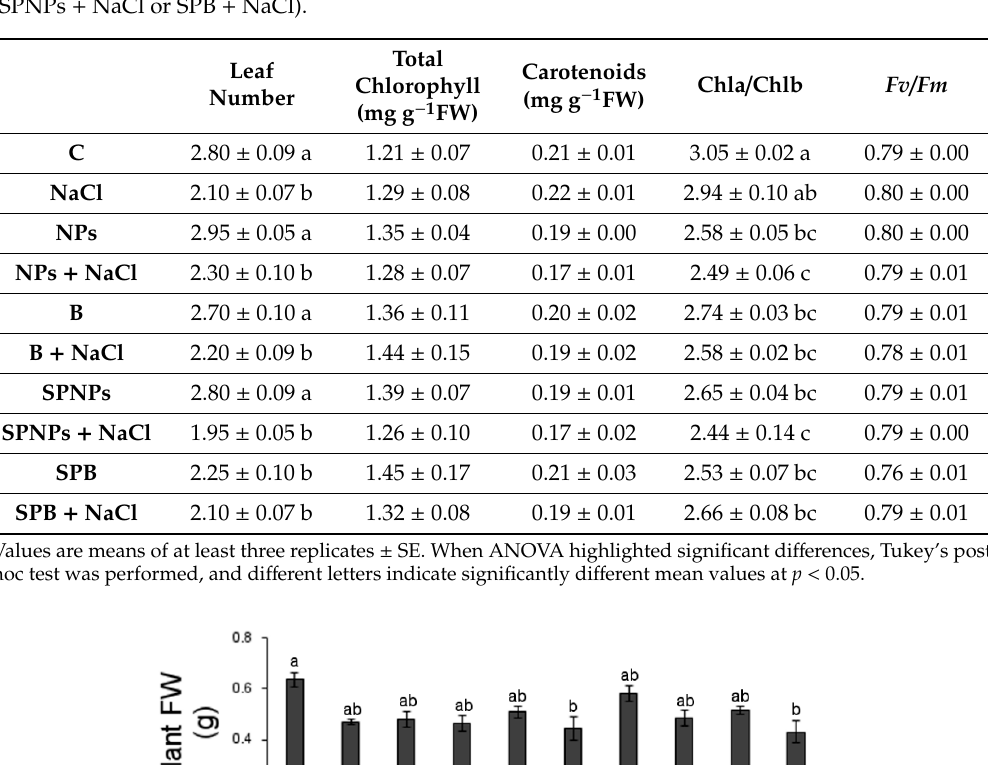
Table 2. Leaf number, pigment concentration, and maximum PSII quantum yield ( Fv / Fm ) in leaves of T. turgidum L. ssp. durum cv. Cappelli without priming and salt treatment (C), with salt treatment without priming (NaCl), with ZnO treatment in the root zone (nanoparticles, NPs or bulk form, B), with ZnO priming in the root zone with salt treatment (NPs + NaCl or B + NaCl), with ZnO treatment as a leaf spray (SPNPs or SPB), and with ZnO priming as a leaf spray with salt treatment (SPNPs + NaCl or SPB + NaCl).